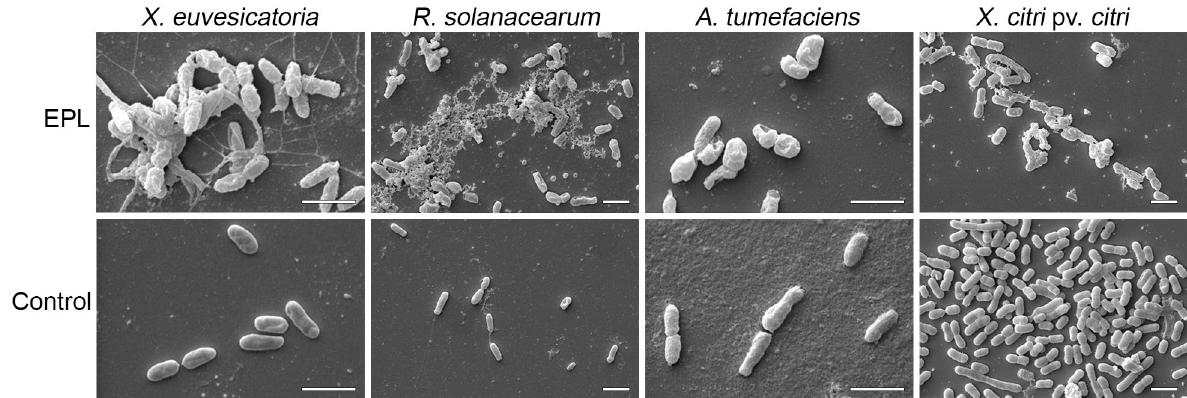
Figure 5. The effect of EPL on the bacterial cell surface. Scanning electron microscopy of bacterial cells treated with EPL at MIC for 1 h. No-EPL (water) treatment was used as control. Scanning electron microscope was operated at 10 kV. Scale bar = 1 μm.